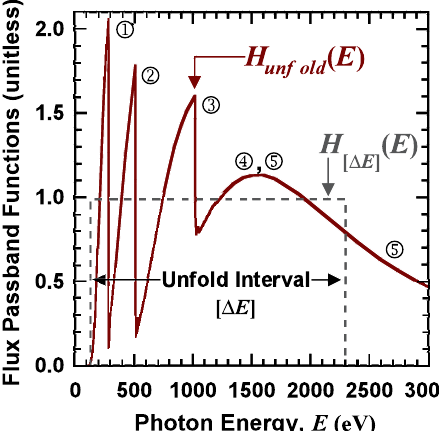
FIG. 4. Passband functions H ½ (cid:1) E (cid:5) ð E Þ and H unfold ð E Þ for the incident flux F ½ (cid:1) E (cid:5) and unfolded flux estimate F unfold , respec- tively. The encircled numbers indicate roughly where specific response functions (Pt. 1: Fig. 1) dominate H unfold ð E Þ